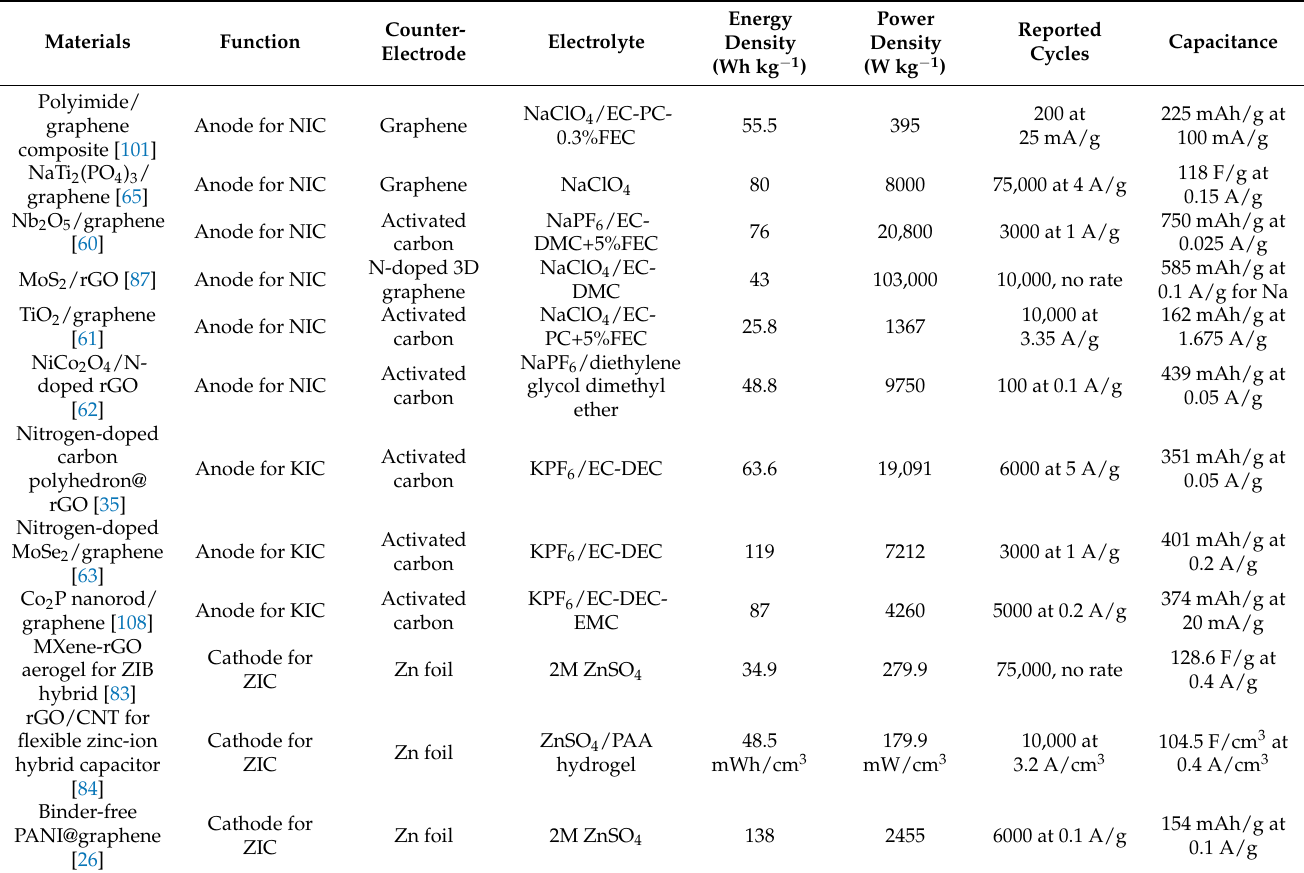
Table 3. Graphene composites for post-Li hybrid